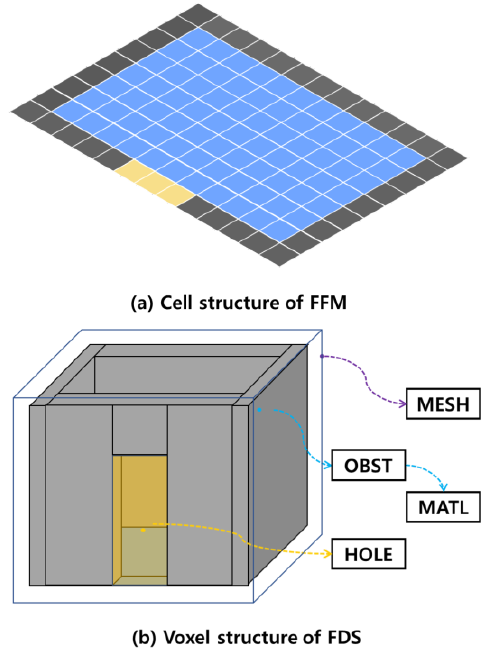
Figure 5. Spatial data